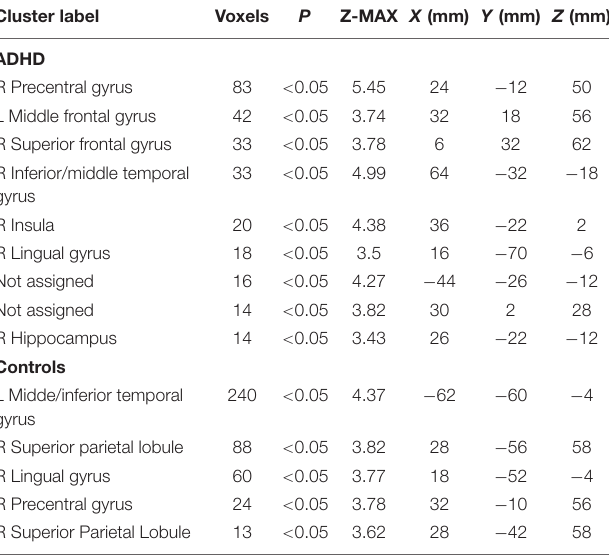
TABLE 3 | Neural correlates of reactive